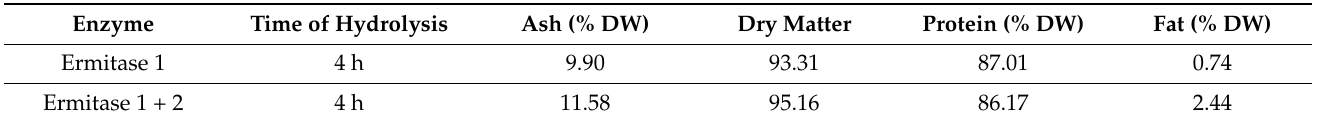
Table 3. The ash, dry matter, protein, and fat content of the soluble protein fraction after treatment with ERM 1 and ERM 1 + 2 for 4